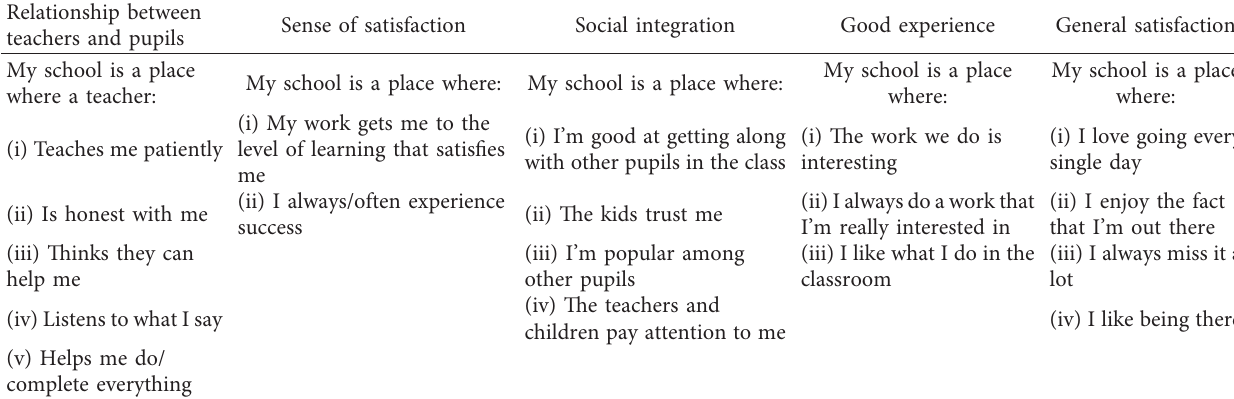
Table 2: Example of the school’s quality-of-life scale (according to [17]).